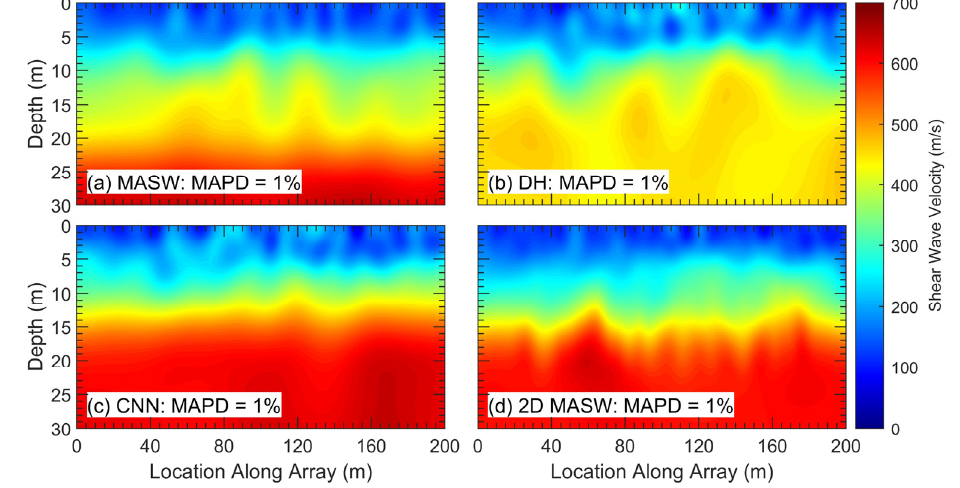
Figure 10. The final, updated 2D V S images at the end of FWI Stage 4 (10 to 30 Hz) for the: ( a ) MASW, ( b ) DH, ( c ) CNN, and ( d ) 2D MASW starting models. Mean absolute percent difference values are shown for each updated V S image relative to the V S image from the end of Stage 3.